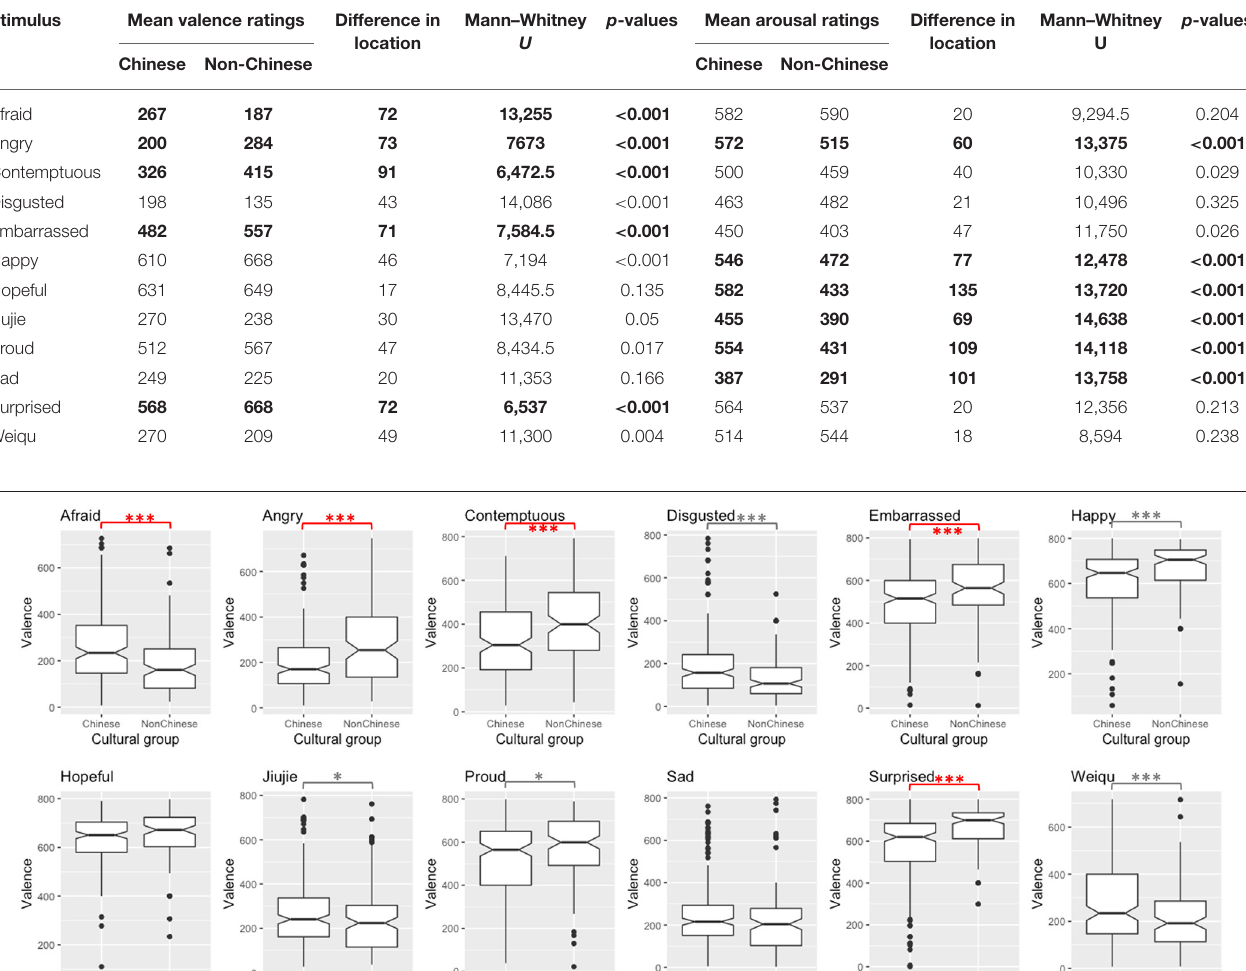
TABLE 2 | Mann–Whitney U analyses for valence and arousal ratings (significant and meaningful differences in bold). Stimulus